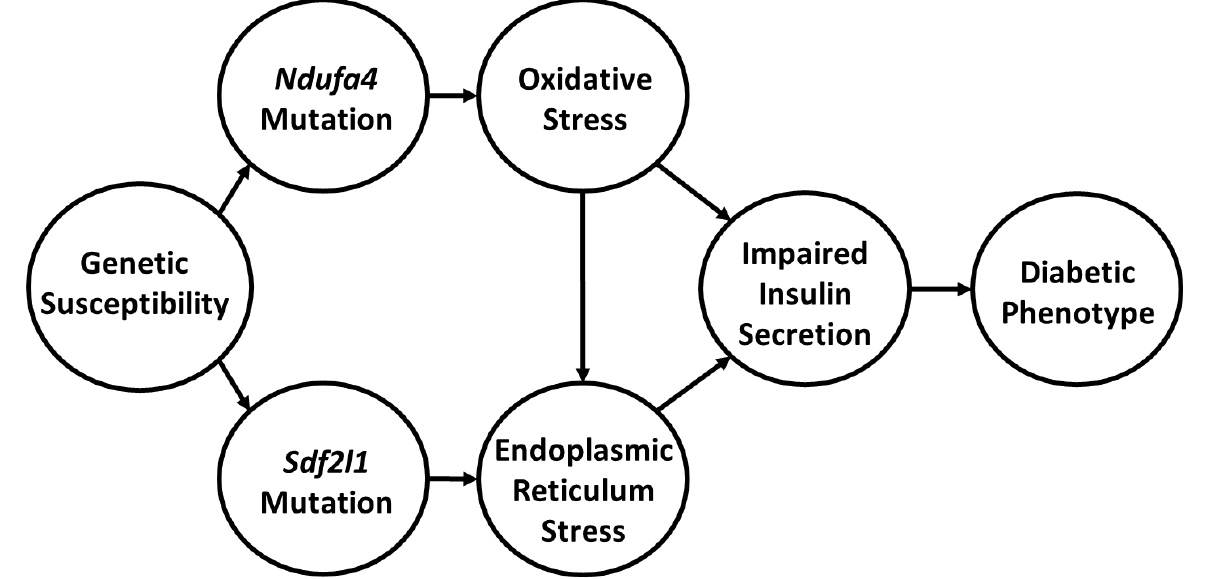
Figure 7. Proposed multi-hit mechanism for the development of the diabetic phenotype in